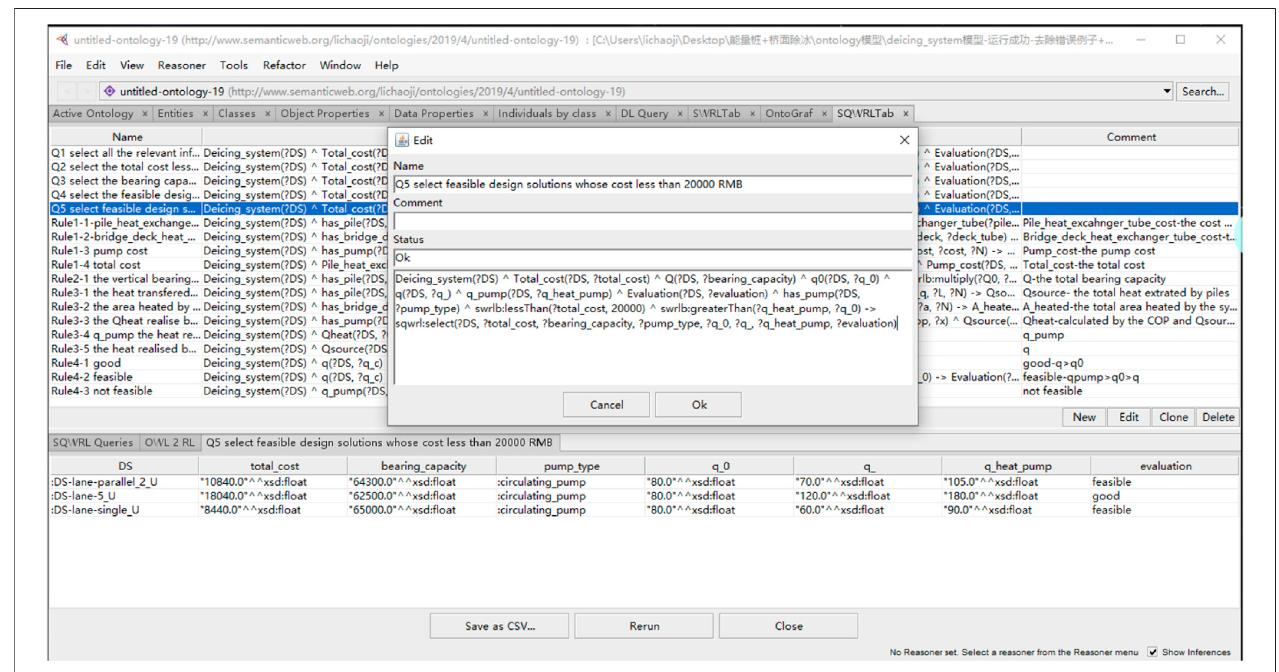
FIGURE 14 | Execution and results of querying Table 10